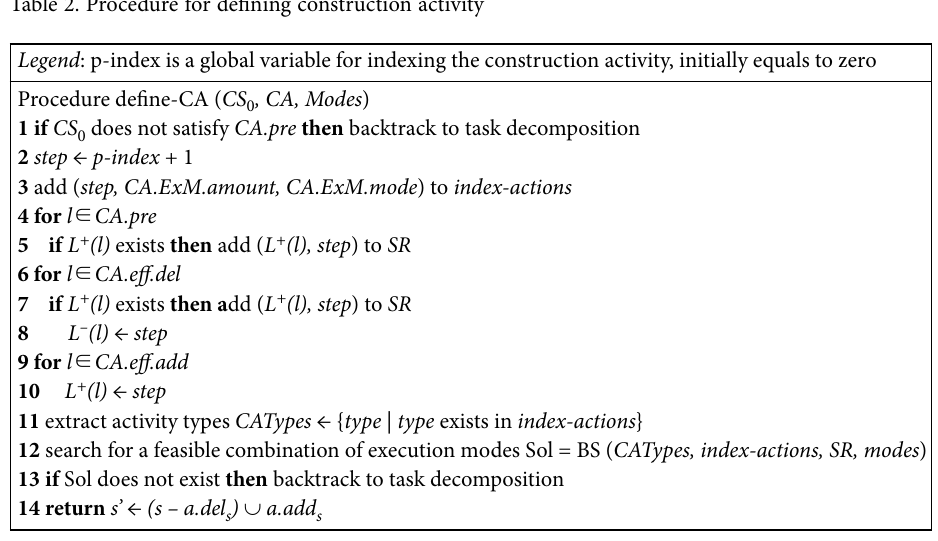
Table 2. Procedure for defining construction